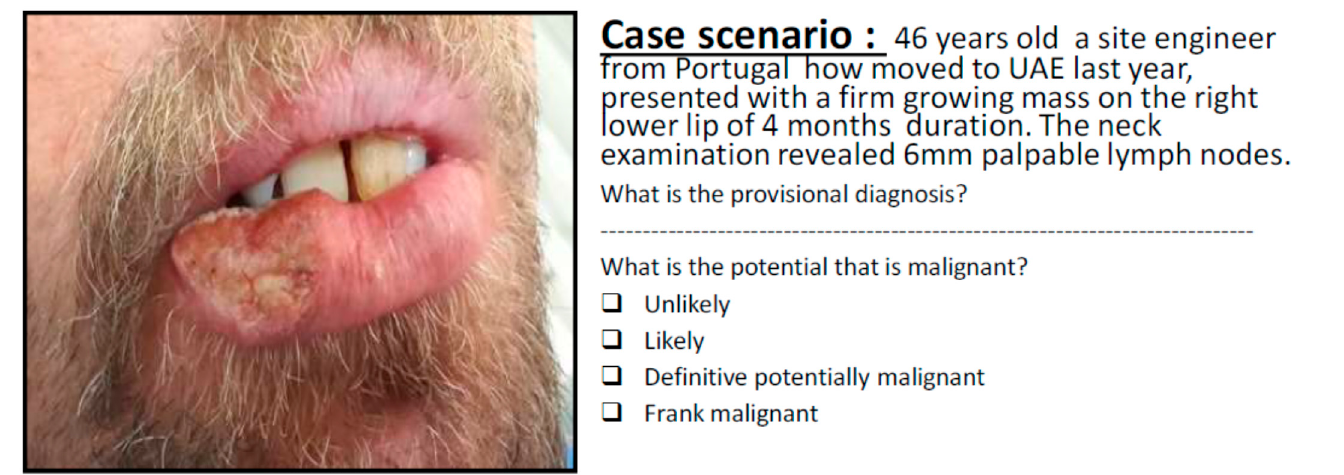
Figure 1. A case scenario representative of malignancy arising on the lower lip.